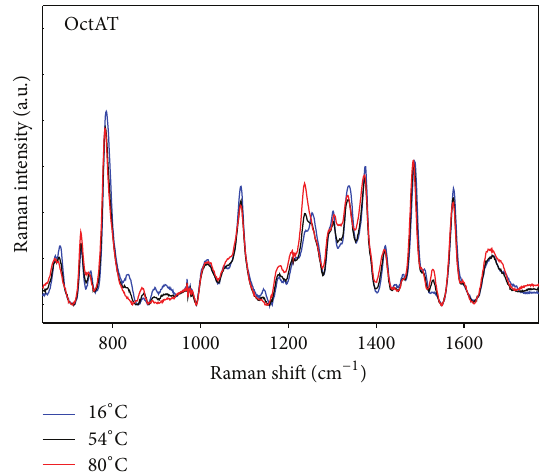
Figure 1: Typical background-corrected Raman spectra of self- complementary DNA octamer (data for OctAT) at temperatures when duplexes are formed (in blue), in the melting region (in black), and when only separated strands are present (in